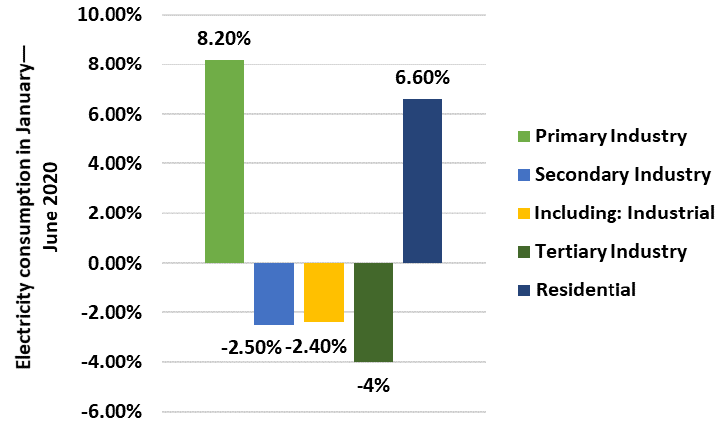
Figure 10. Sector-wise electricity consumption in January–June 2020.